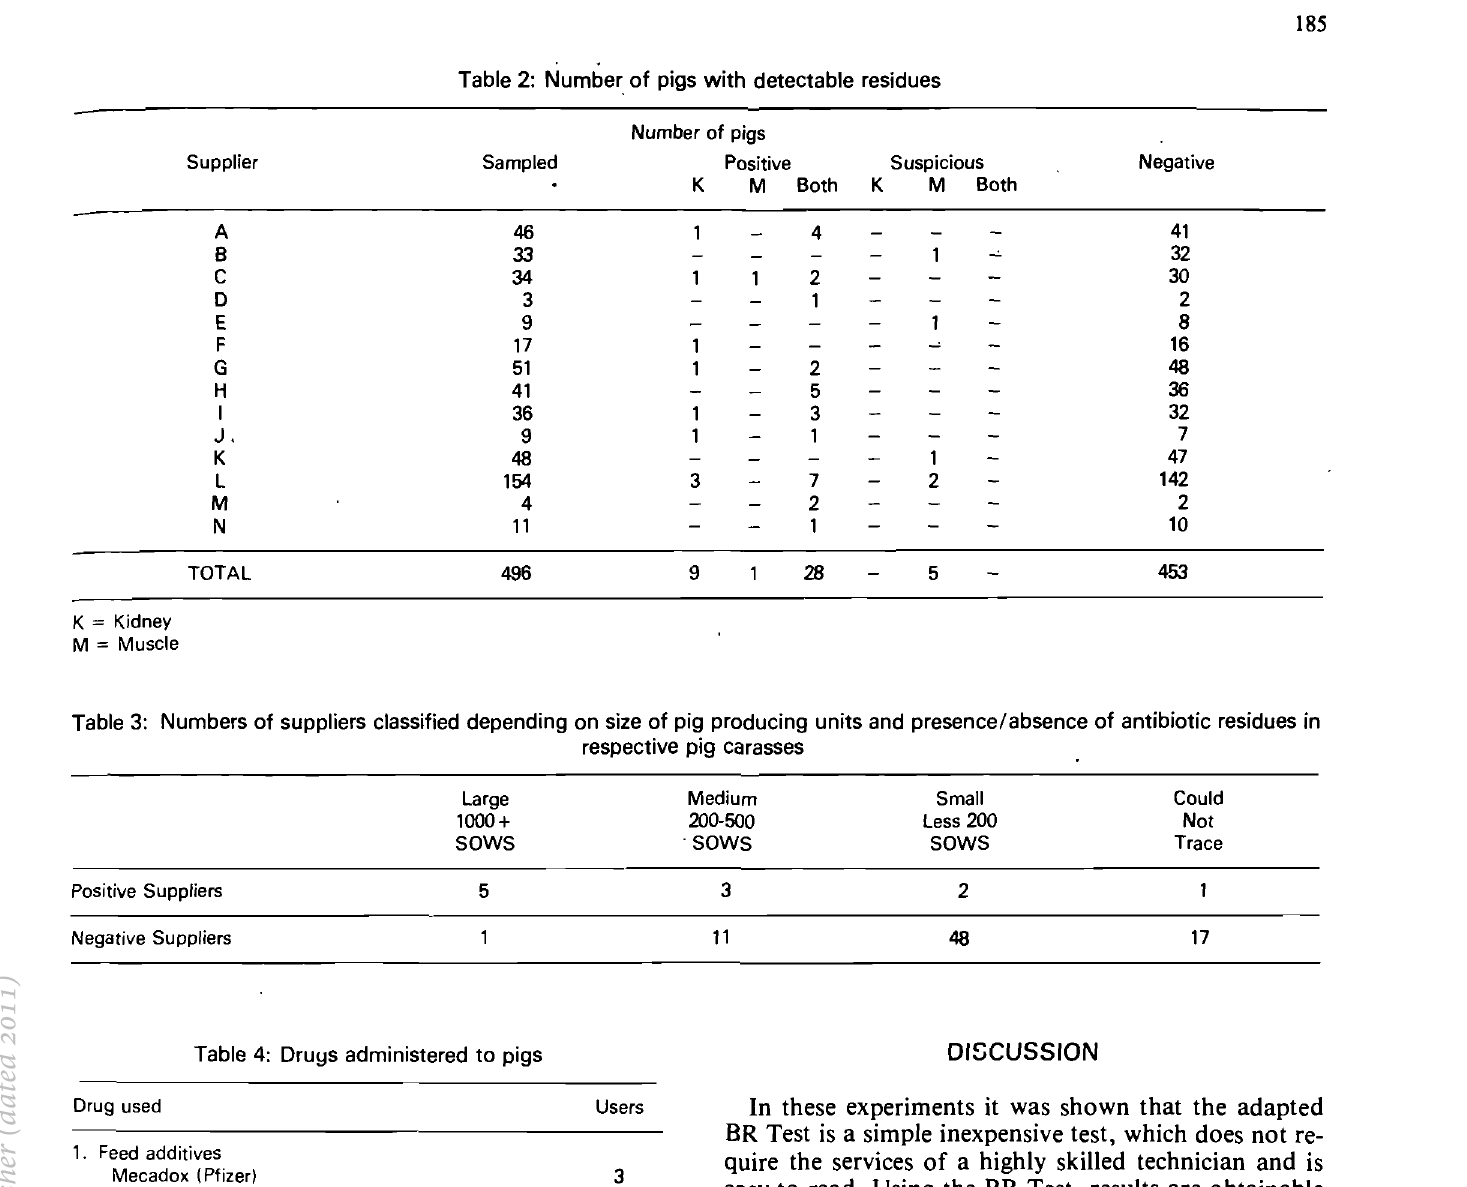
Table 2: Number of pigs with detectable residues